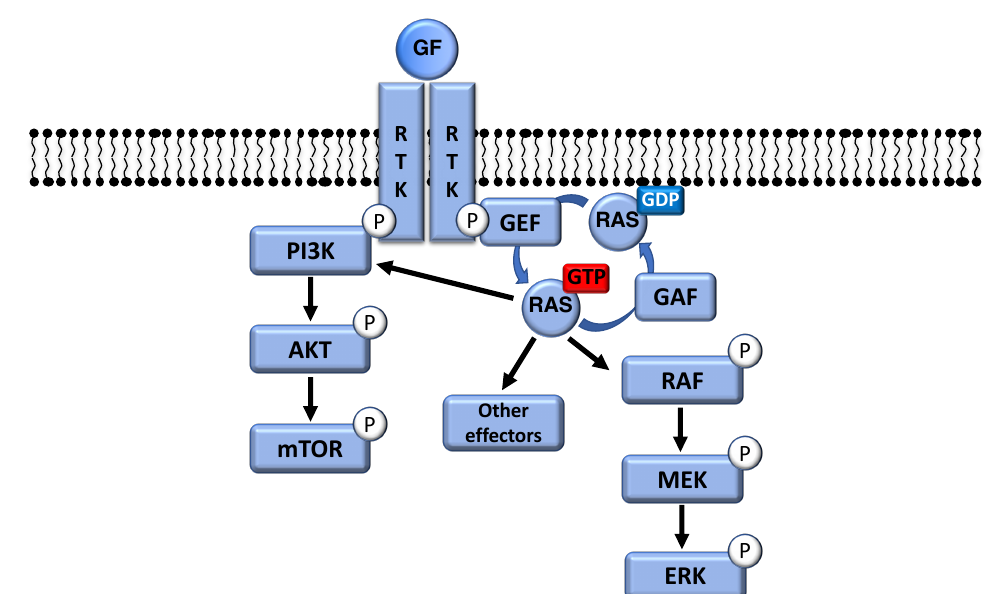
Figure 1. The PI3K / AKT / mTOR and the RAS / RAF / MEK / MAPK pathways. GAF: GTPase Figure 1: The PI3K/AKT/mTOR and the RAS/RAF/MEK/MAPK pathways. GAF: GTPase activating protein, GEF: guanine nucleotide exchange factor; GF: growth factor; RTK: receptor tyrosine kinase.